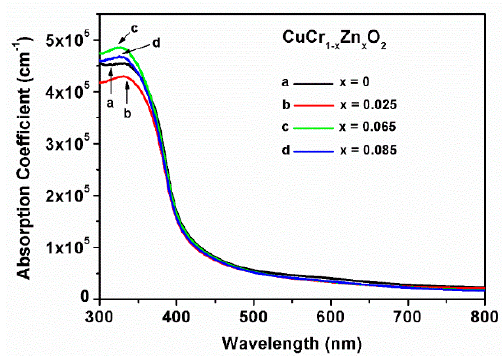
Figure 6. Absorption coefficients of the CuCr 1 − x Zn x O 2 films.